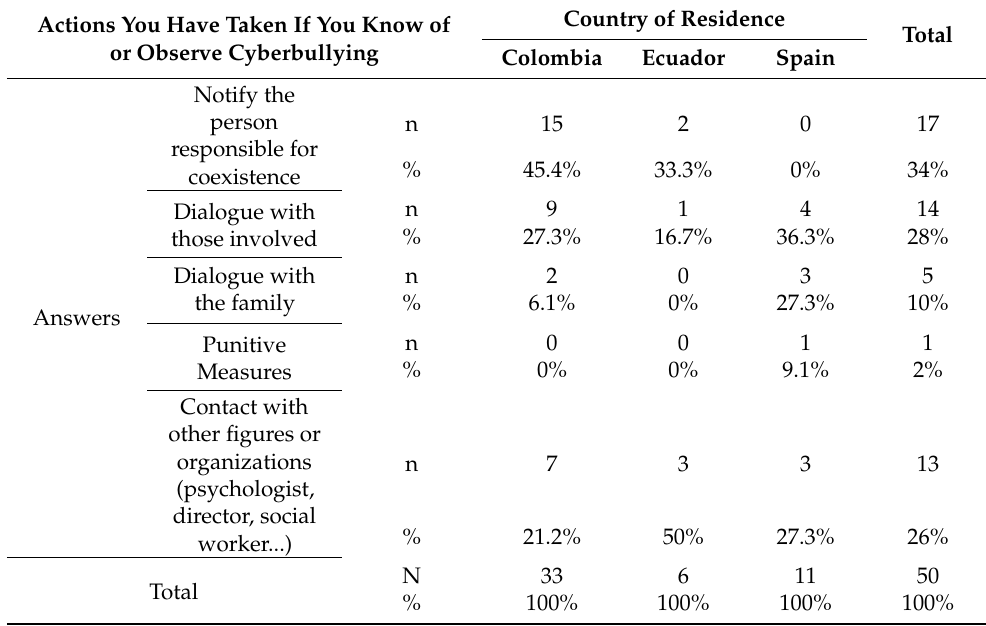
Table 13. Cross-categorization of the variable “Actions you have taken in case of observing cyberbul- lying” and the variable “Country of residence”.